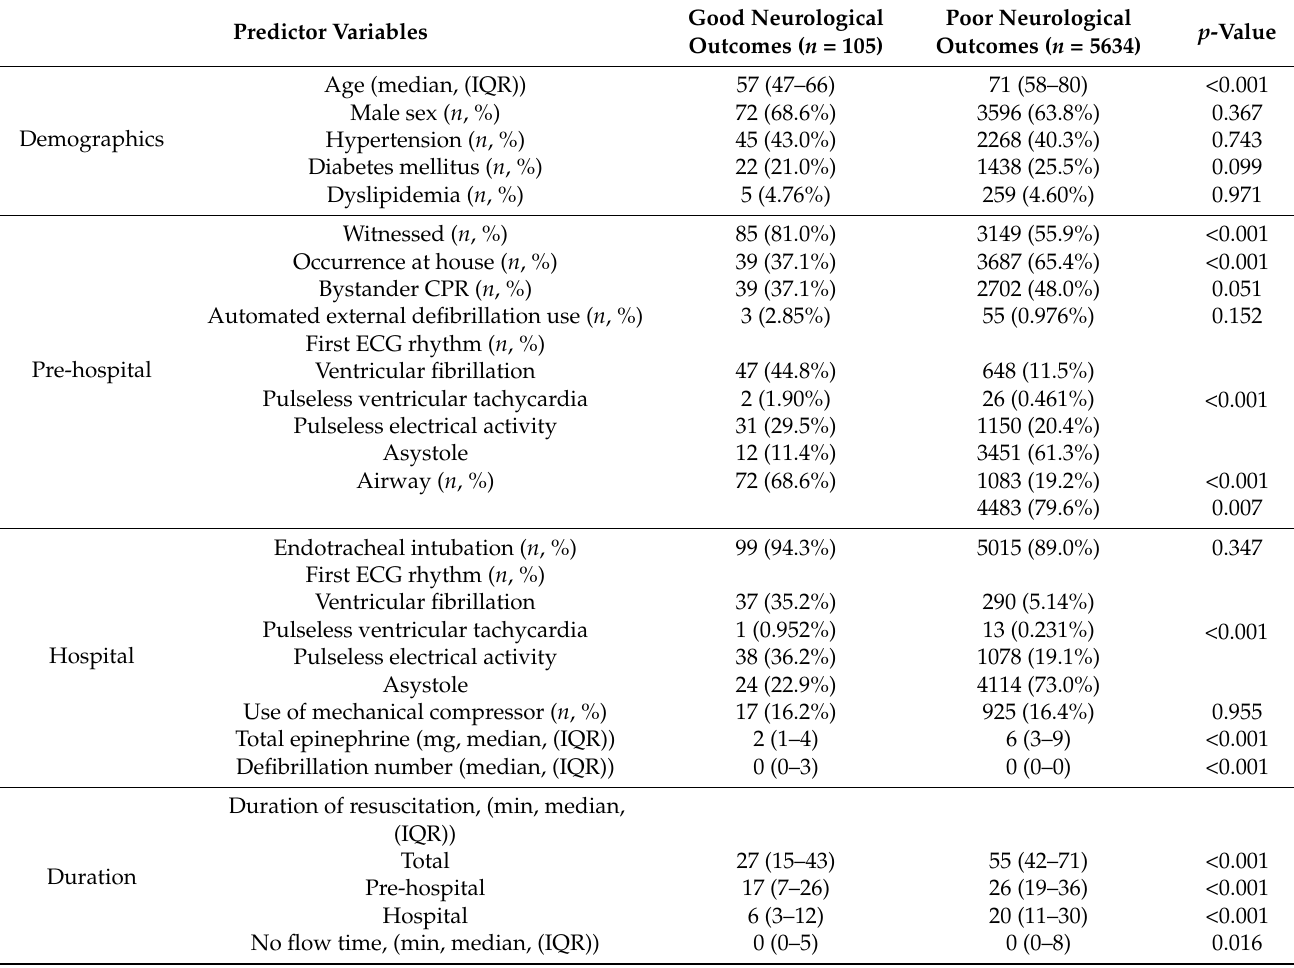
Table 1. Basic statistics of the variables of the study subjects categorized according to neurological outcome. Predictor